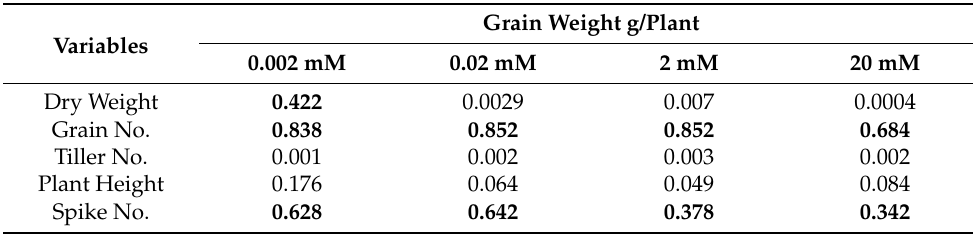
Table 2. Correlation between grain weight g/plant and different variables (shoot dry weight, grain numbers, tiller numbers, plant height and spike numbers). The values in bold are significantly different at <0.05.